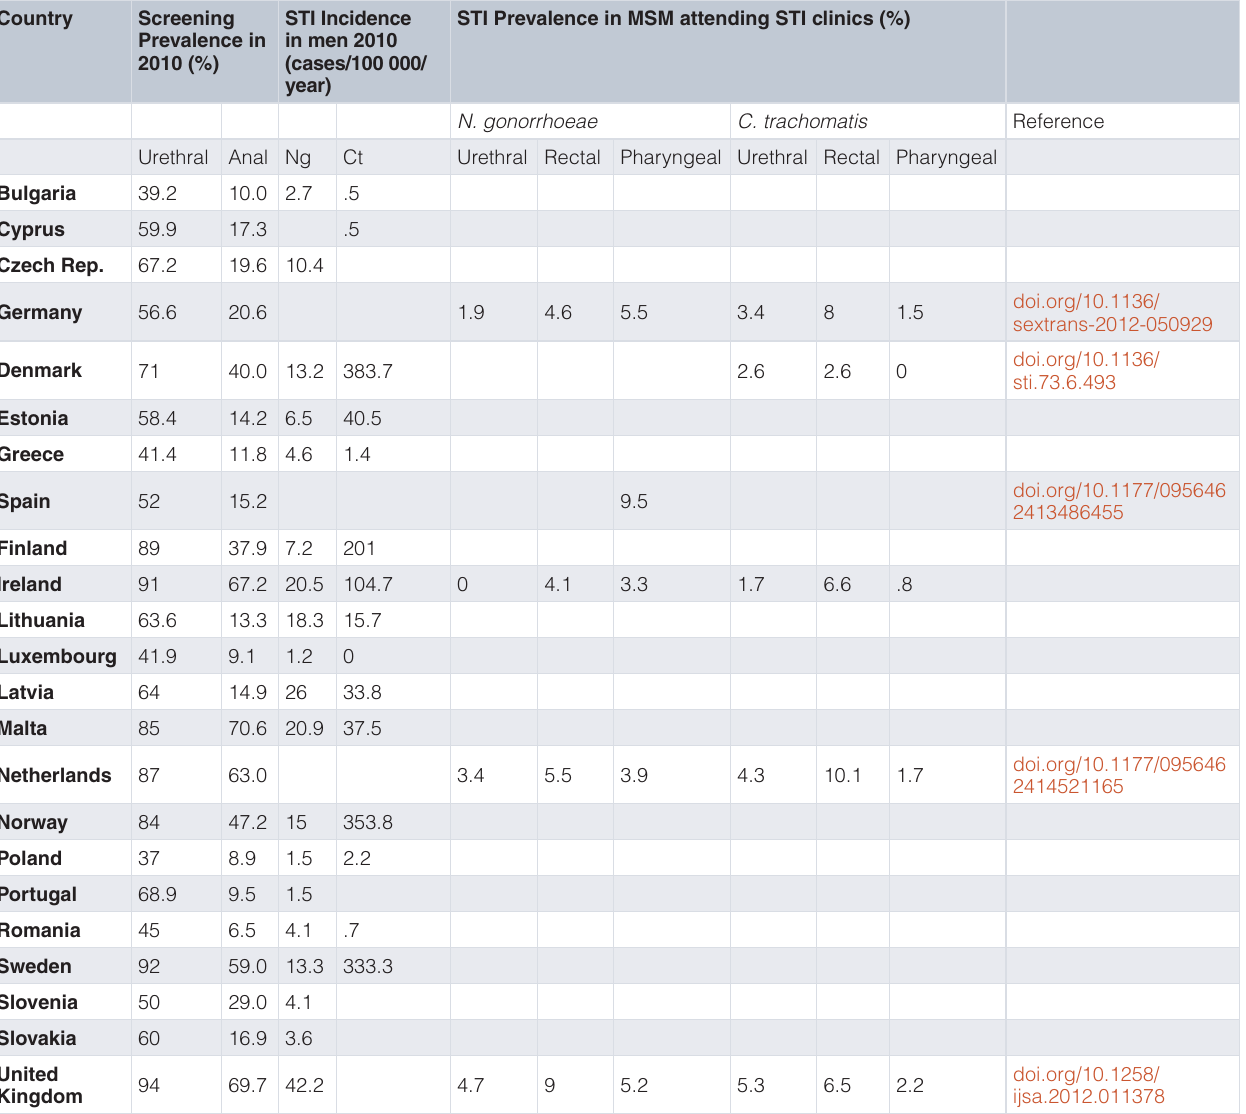
Table 1. Prevalence of sexual transmitted infection (STI) screening, STI incidence and prevalence in European countries with available data. Country Screening Prevalence in